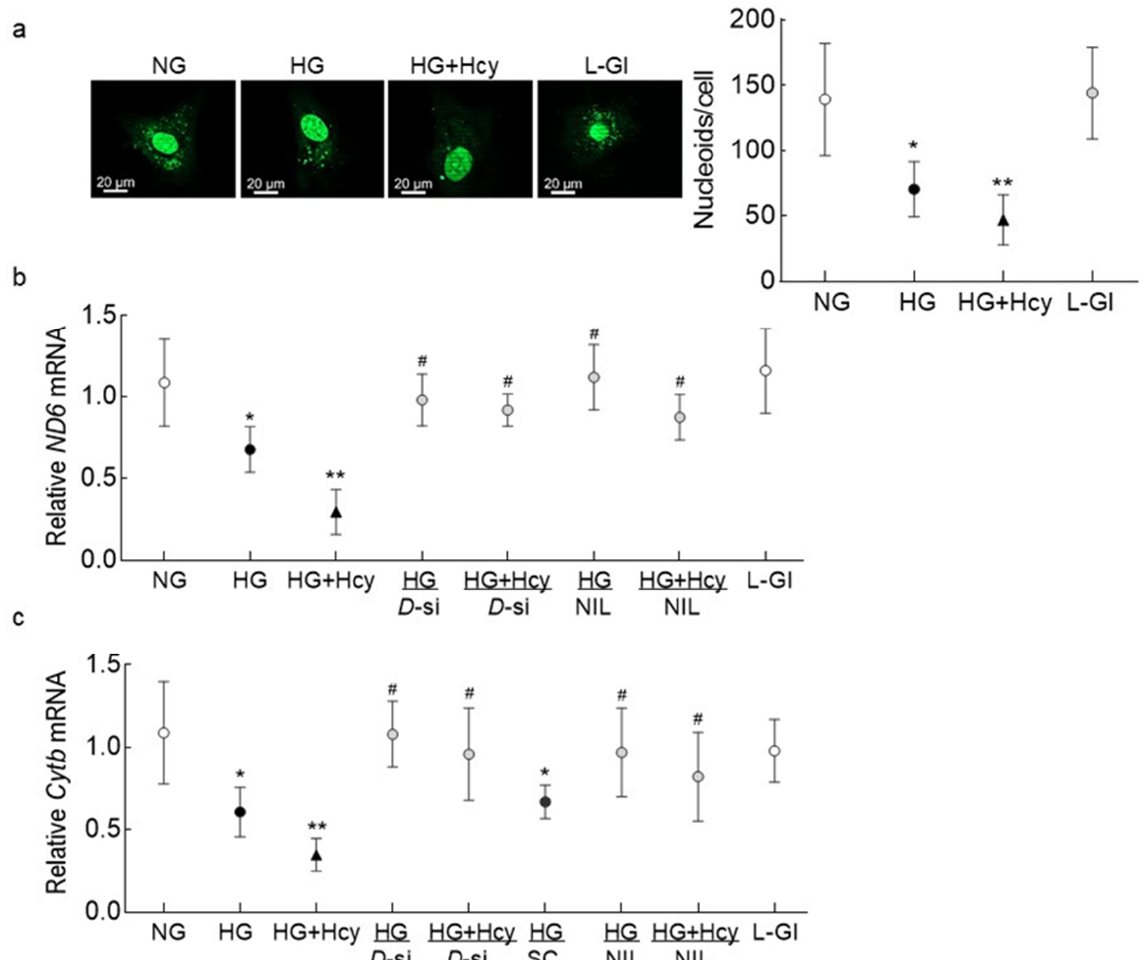
Figure 5. Effect of homocysteine on mitochondrial nucleoids and transcription of mtDNA. ( a ) Nu- cleoids were quantified using SYBR DNA gel stain, and the images were acquired using a 40× objective. The accompanying graph has values represented as mean ± SD obtained from 30–40 cells in each group. Gene transcripts of mtDNA-encoded ( b ) ND6 and ( c ) Cytb were quantified by qRT-PCR using β -actin as a housekeeping gene. The values are represented as mean ± SD obtained from 3–4 different cell preparations with each measurement made in triplicate: NG and HG, cells in normal and high glucose, respectively; HG + Hcy, cells in high glucose and homocysteine; HG/ D -si and HG + Hcy/ D -si, Drp1 -siRNA transfected cells in high glucose or high glucose + homocysteine, respectively; HG/SC, nontargeting scrambled RNA transfected cells in high glucose; HG/NIL and HG + Hcy/NIL, cells in the presence of NIL in high glucose or high glucose + homocysteine, respectively; L-Gl, 20 mM L-glucose; * and ** p < 0.05 vs. NG and HG, respectively; # p > 0.05 vs.